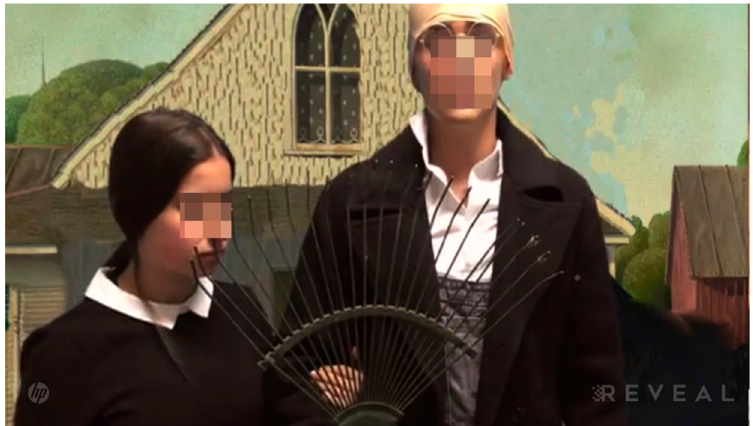
Figure 2. The result of one project: any person with a mobile phone or tablet, using the HP Reveal app, can access an augmented reality video that shows the characters of a painting (in this case, American Gothic , by Grant Wood, 1930) coming alive and explain the historical and cultural context of the master piece (the face of the students has been pixelated to ensure